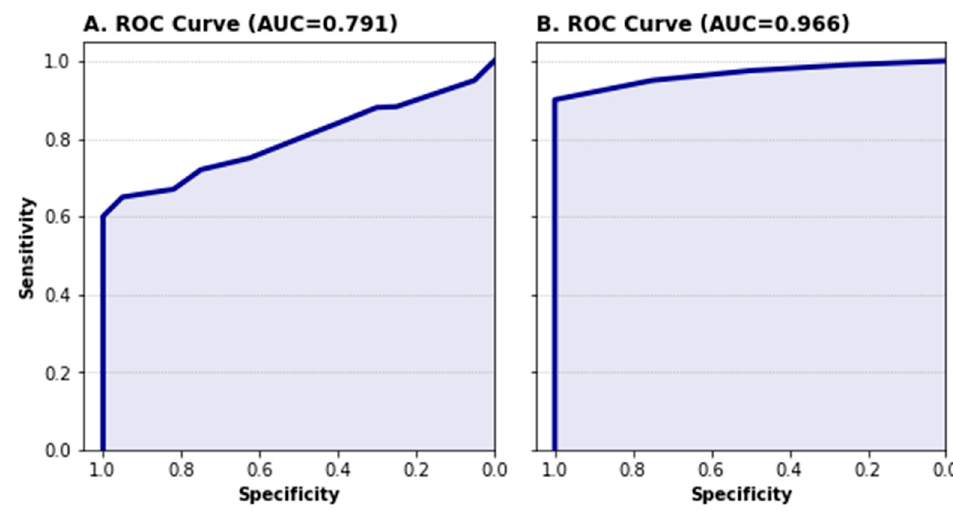
Figure 7. ROC curve analysis of ( A ) Cundinamarca’s FLCI and ( B ) Magdalena’s FLCI, respectively.